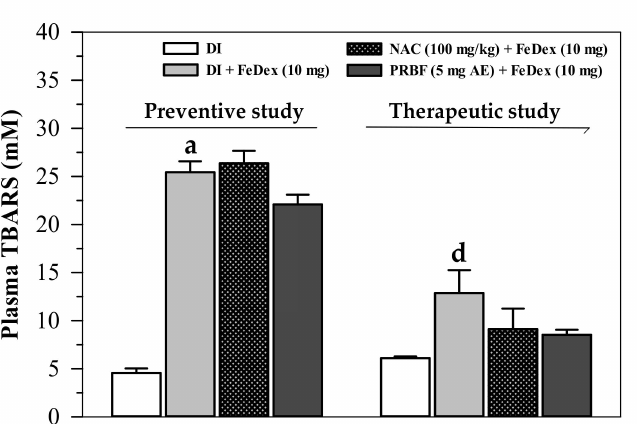
Figure 5. Levels of TBARS in the plasma collected from FeDex-loaded mice that had been treated with DI, NAC and PRBF. In the preventive study, mice were treated with DI, NAC (100 mg/kg) and PRBF (5 mg AE/kg) for 14 d. This was followed by a single ip injection with 10 mg FeDex after the last oral dose was administered on day 14. Mice were then sacrificed; their heart blood was collected and TBARS concentrations in the plasma were determined. In the therapeutic study, mice were ip injected with 10 mg FeDex together with DI, NAC (100 mg/kg) and PRBF (5 mg AE/kg) for 14 d. Mice were then sacrificed, their heart blood was collected and plasma TBARS concentrations were determined. Data are expressed as mean ± SD values ( n = 6). a p < 0.05 when compared with DI alone in the preventive study; d p < 0.05 when compared with DI alone in